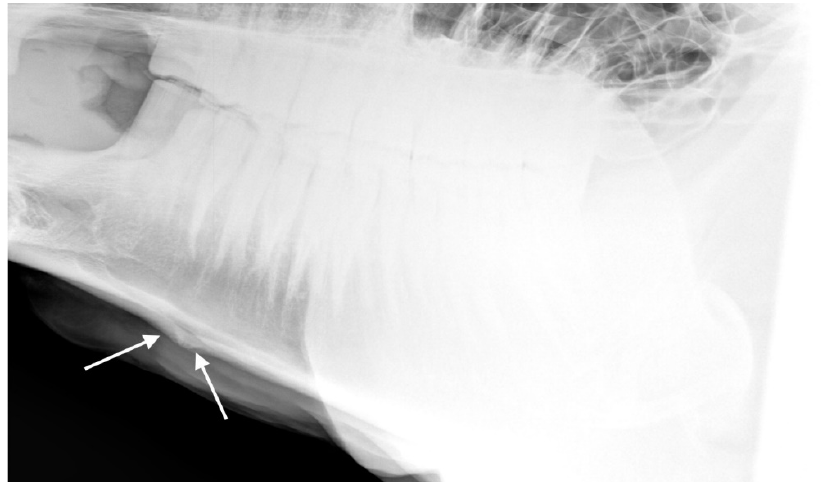
Figure 9. Radiograph showing the mandible of a horse in which radiologists ( n = 2) agreed there was loss of mandibular homogeneity. Animals 2020 , 10 , x FOR PEER REVIEW 14 of 20